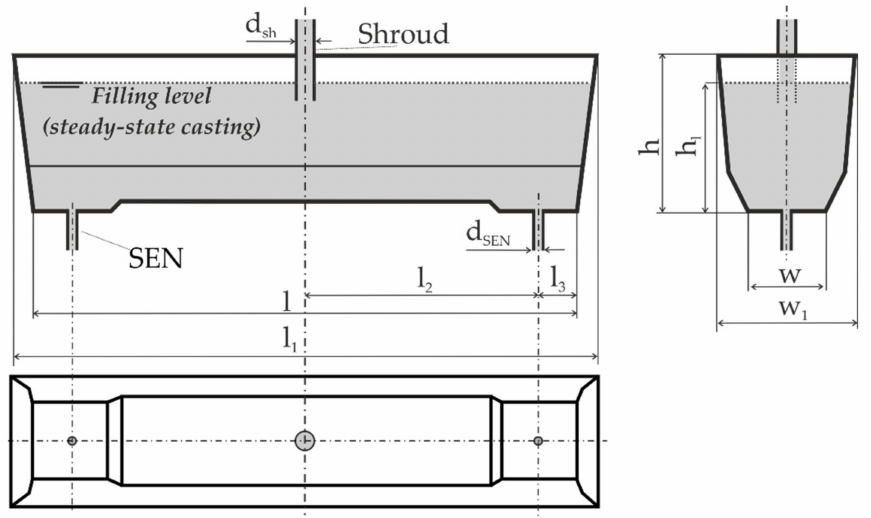
Figure 1. Scheme of the investigated tundish with designations of selected